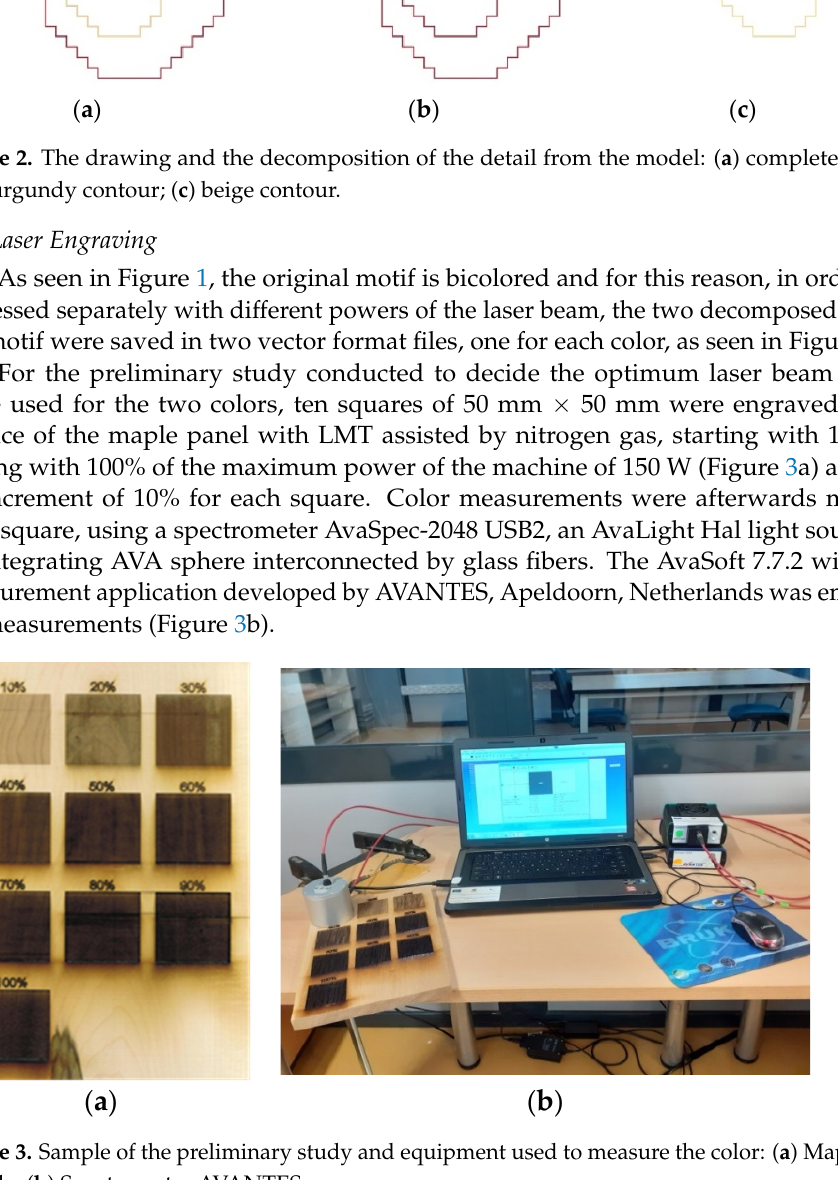
Figure 4. An example of color measurement results, including L , a , b CIELab parameters. The mean values of L , a , b for the ten color measurements of the control sample and five measurements of each laser engraved square surface, alongside the standard devia- tions were calculated. In order to evaluate the difference between two colors, the color difference Δ E was calculated as the distance between two points in the CIELab color space, according to Equation (1): ∆𝐸 (cid:3404) (cid:3493)𝑑𝐿 (cid:2870) (cid:3397) 𝑑𝑎 (cid:2870) (cid:3397) 𝑑𝑏 (cid:2870) (1) where: dL is the difference in lightness, da is the difference in red-green coordinate a , db is the difference in the yellow-blue coordinate b , and Δ E is the total color difference in the two colors to compare [24]. Differences between the average values measured on the laser engraved wood surfaces and the average values measured on the control sample surface were employed to calculate the resulting color differences as a function of the laser power. The calculated color difference values were used as a basis to select the appropriate laser processing parameters to obtain engraved motifs with color differences as close as possible to those existing on the real model on the clothing object. If close calculated Δ E values are obtained for both the original colors of the motif and for the laser engraved surface, then similar contrasts are expected for the original and the laser engraved motif. The laser beam powers rendering colors with similar contrast as the original motif will be further employed to process the entire ornament on the maple wood surface. In order to measure the color difference ( Δ E) between the original colors of the motif taken from the textile heritage, first the contour in vector format of the drawing was filled in colors selected from Figure 1b using the graphic program (Figure 5a). Squares of 50 mm × 50 mm drawn and filled with the two colors (Figure 5b,c) were printed on an A4 format of white cardboard. For burgundy and beige squares, five measurements of L , a and b